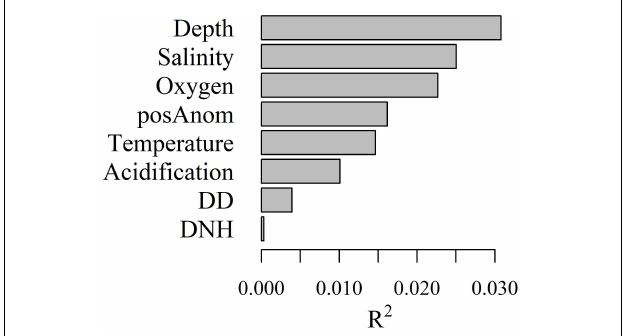
FIGURE 4 | Overall importance, R 2 p , of each predictor p included in the gradient forest analysis.